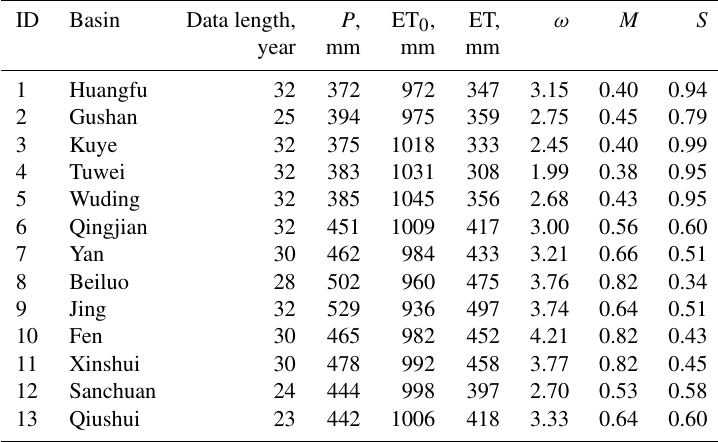
Figure 1. Locations of the study area and hydrometeorological stations. Table 1. Long-term hydrometeorological characteristics and vegetation coverage (1981–2012). Because a few runoff data points were missing for several basins, the data length in these basins was less than 32. Each item represents the mean annual